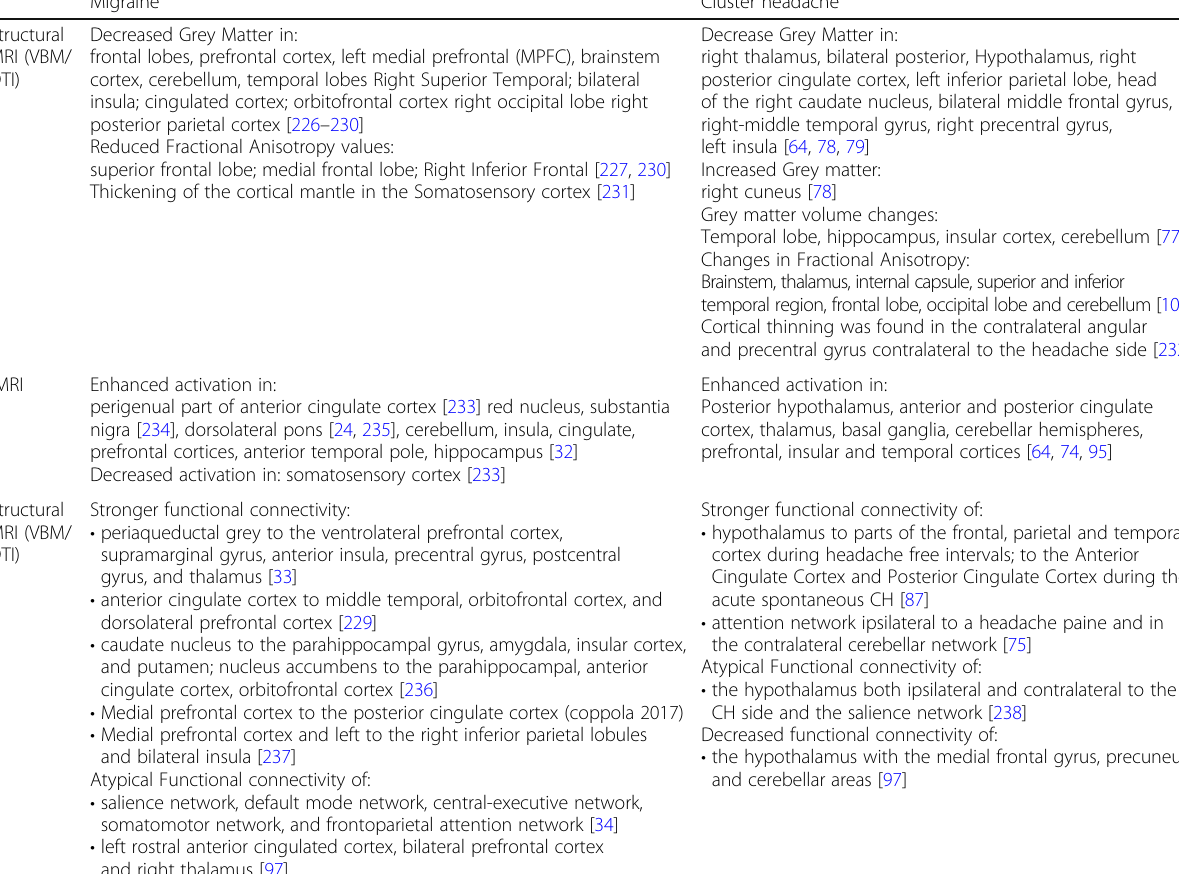
Table 2 Structural and Functional abnormalities in migraine and cluster headache Migraine Cluster headache Structural MRI